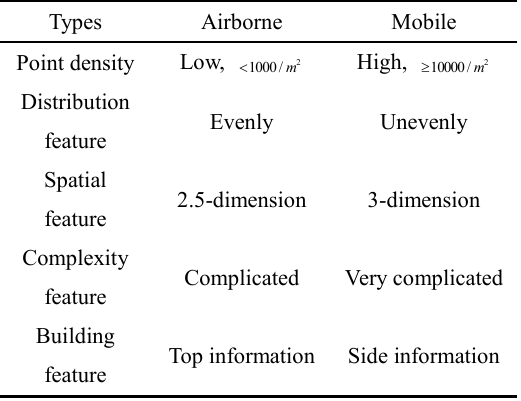
Table 1.Differences between airborne and mobile LiDAR point cloud